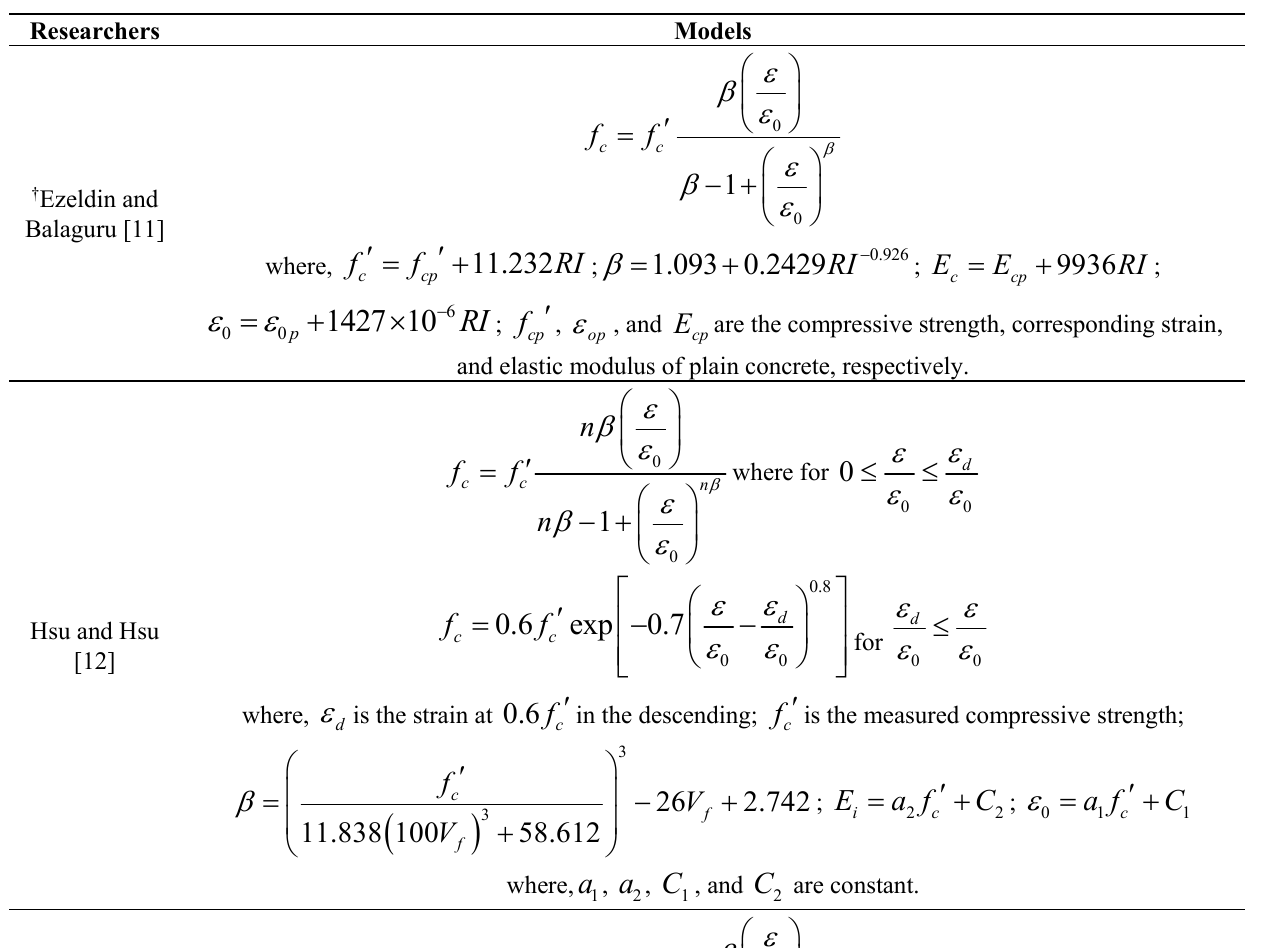
Table 1. Models for the compressive behavior of fiber reinforced